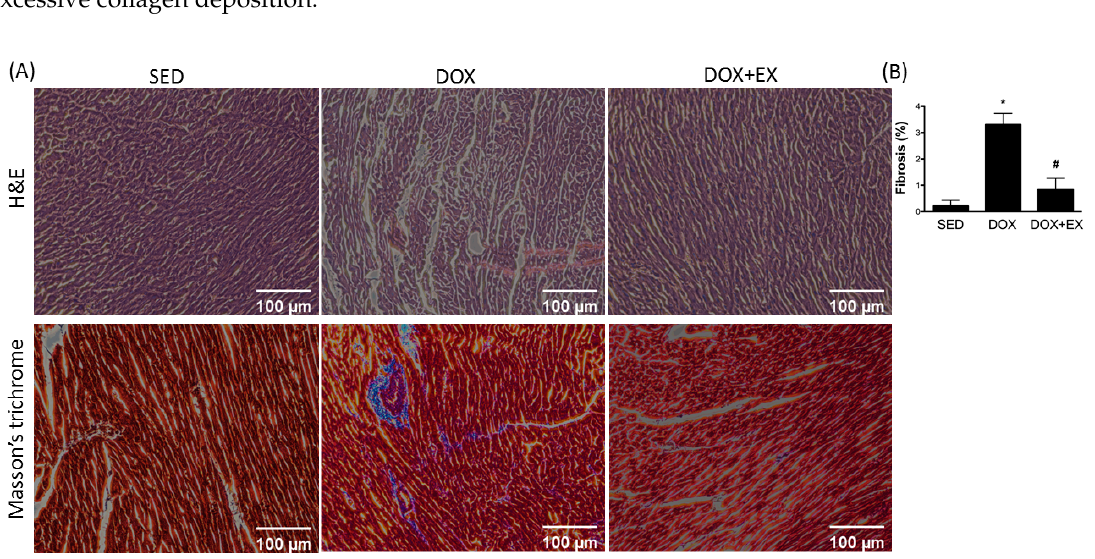
Figure 4. Masson’s trichrome staining of the cardiac tissues. Representative image ( A ) and quantification ( B ) of the fibrosis areas. * p < 0.05 compared to the SED group. # p <0.05 compared to the DOX group.